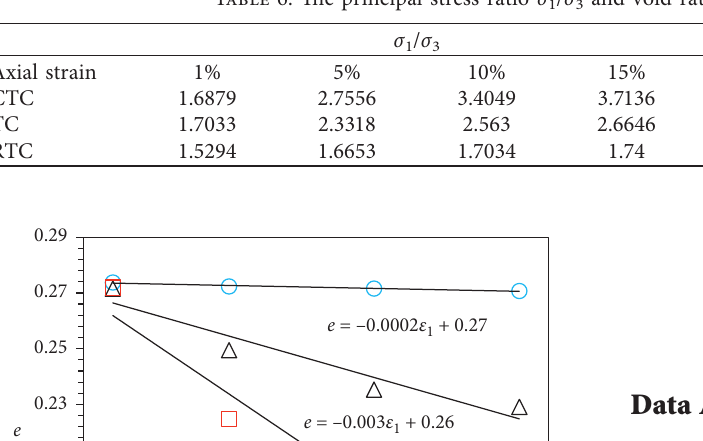
Table 6: The principal stress ratio σ 1 / σ 3 and void ratio e under different stress paths.